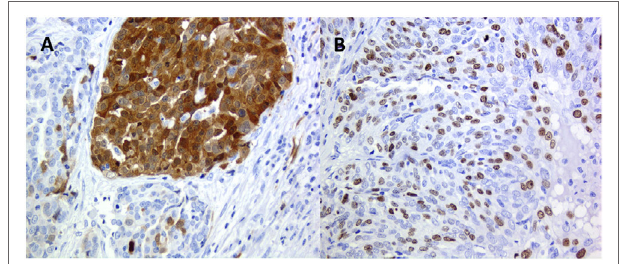
FiGURe 3 | High-grade ovary serus carcinoma: (A) p16 clonal type intra-tumor heterogeneity (ITH) and (B) Ki67 stochastic